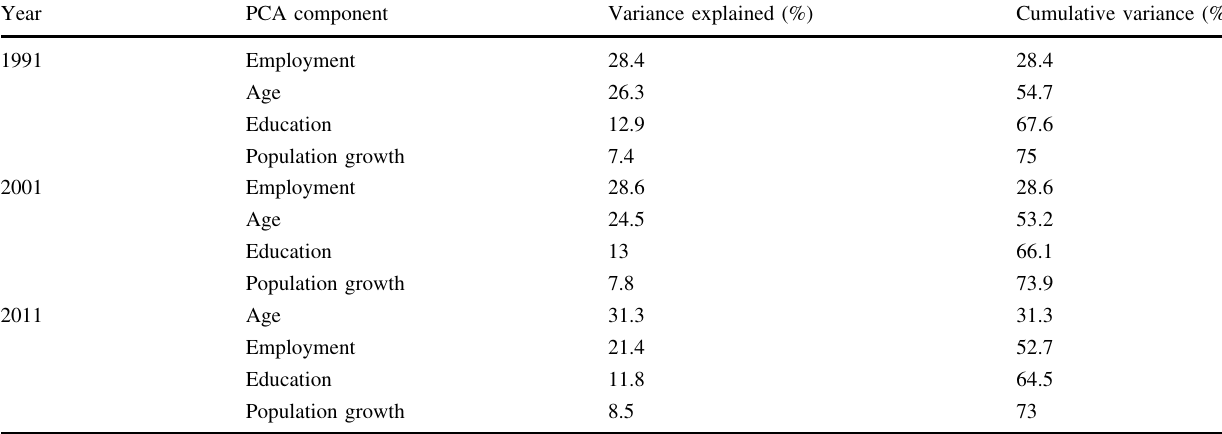
Table 3 PCA results: the first four components and the variance explained for year 1991, 2001, and 2011 Year